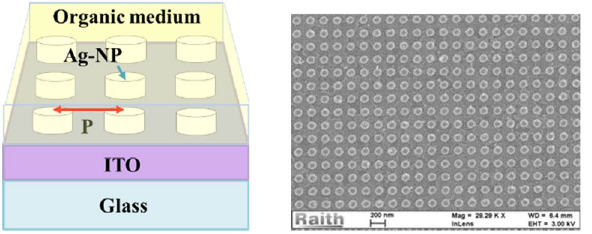
Figure 1. The studied sample and a SEM image of the realized Ag nanoparticle grating at a period of 280